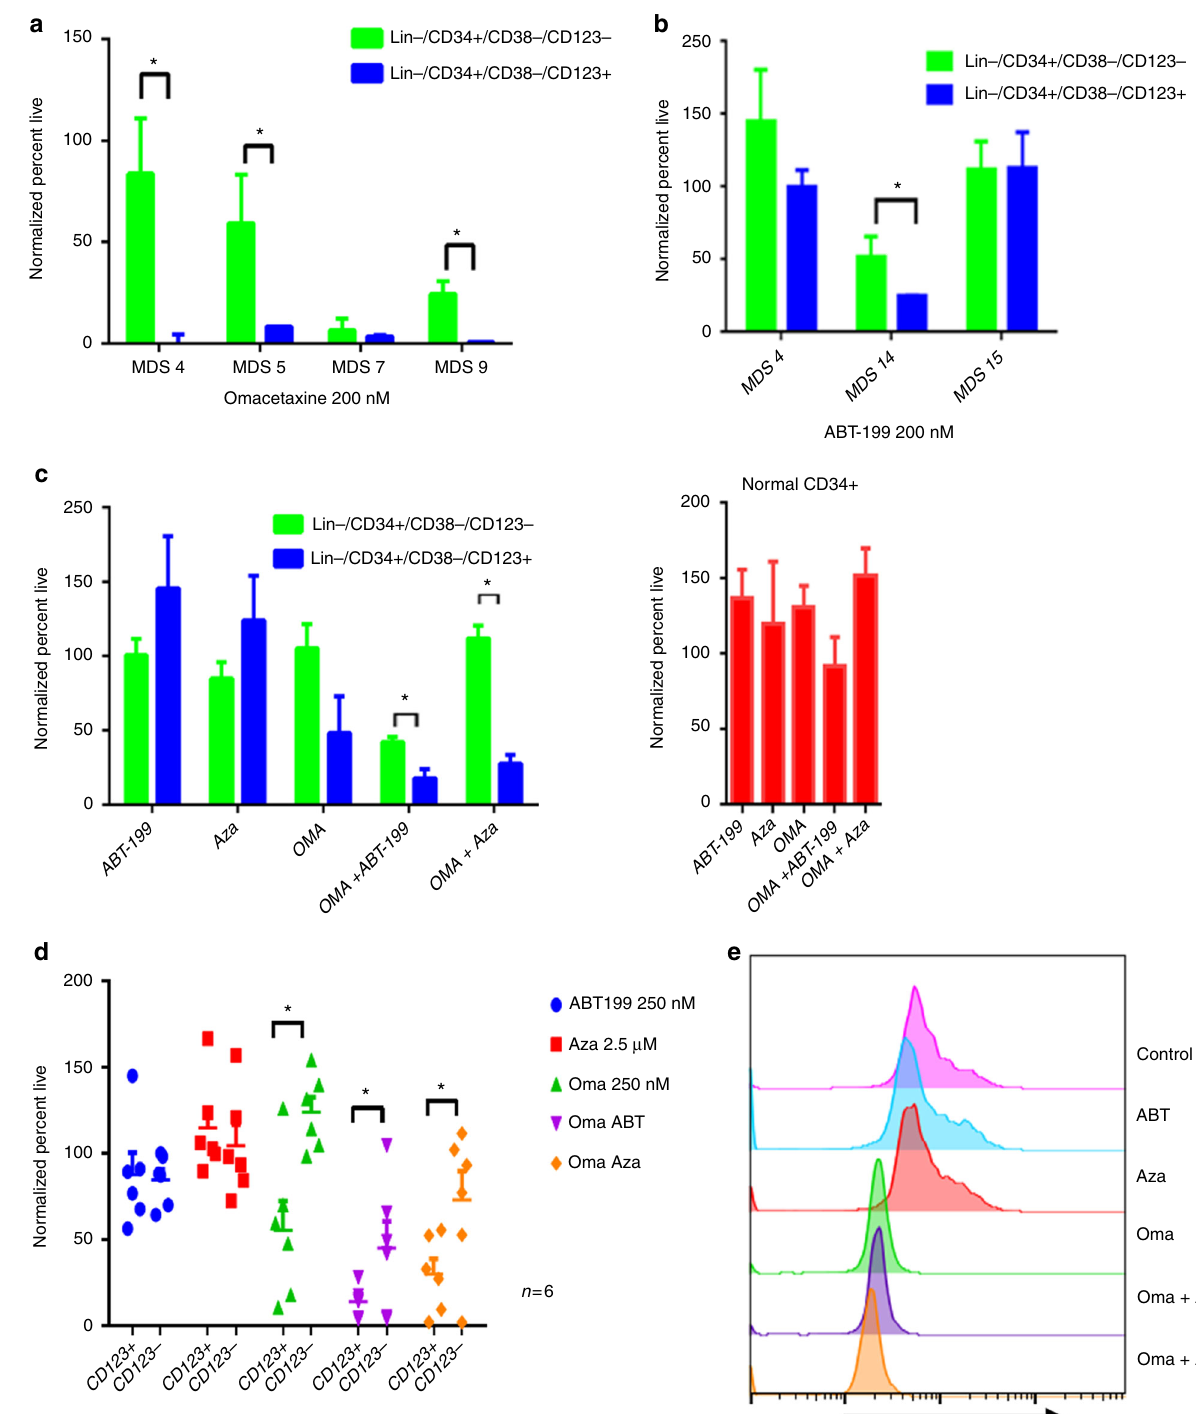
Fig. 5 CD123 positive cells show differential sensitivity to multiple agents. Viability of primary MDS specimens following overnight culture in the presence of 200 nM omacetaxine, a protein synthesis inhibitor ( a ), or 200 nM ABT-199, a Bcl2 inhibitor ( b ). Data gated on CD123- vs. CD123 + primitive populations (Lin − /CD34 + /CD38 − ). c Viability of a typical MDS specimen following overnight culture in varying drug conditions (left panel) in comparison to normal bone marrow CD34 + cells (right panel). ABT-199 (200 nm), OMA (omacetaxine, 200 nM), and Aza (azacitidine, 2.5uM). * indicates p < 0.01; bars represent mean ± S.D. from three replicates. d Six independent patient samples showing toxicity to drugs used in panel c comparing CD123 + vs. CD123- cells. e Protein synthesis levels following 4 h of treatment with omacetaxine,ABT-199, azacitidine, omacetaxine plus ABT- 199, or omacetaxine plus azacitidine as indicated by OP-puromycin labeling. * p < .05 (two-tail t -test) error bars are